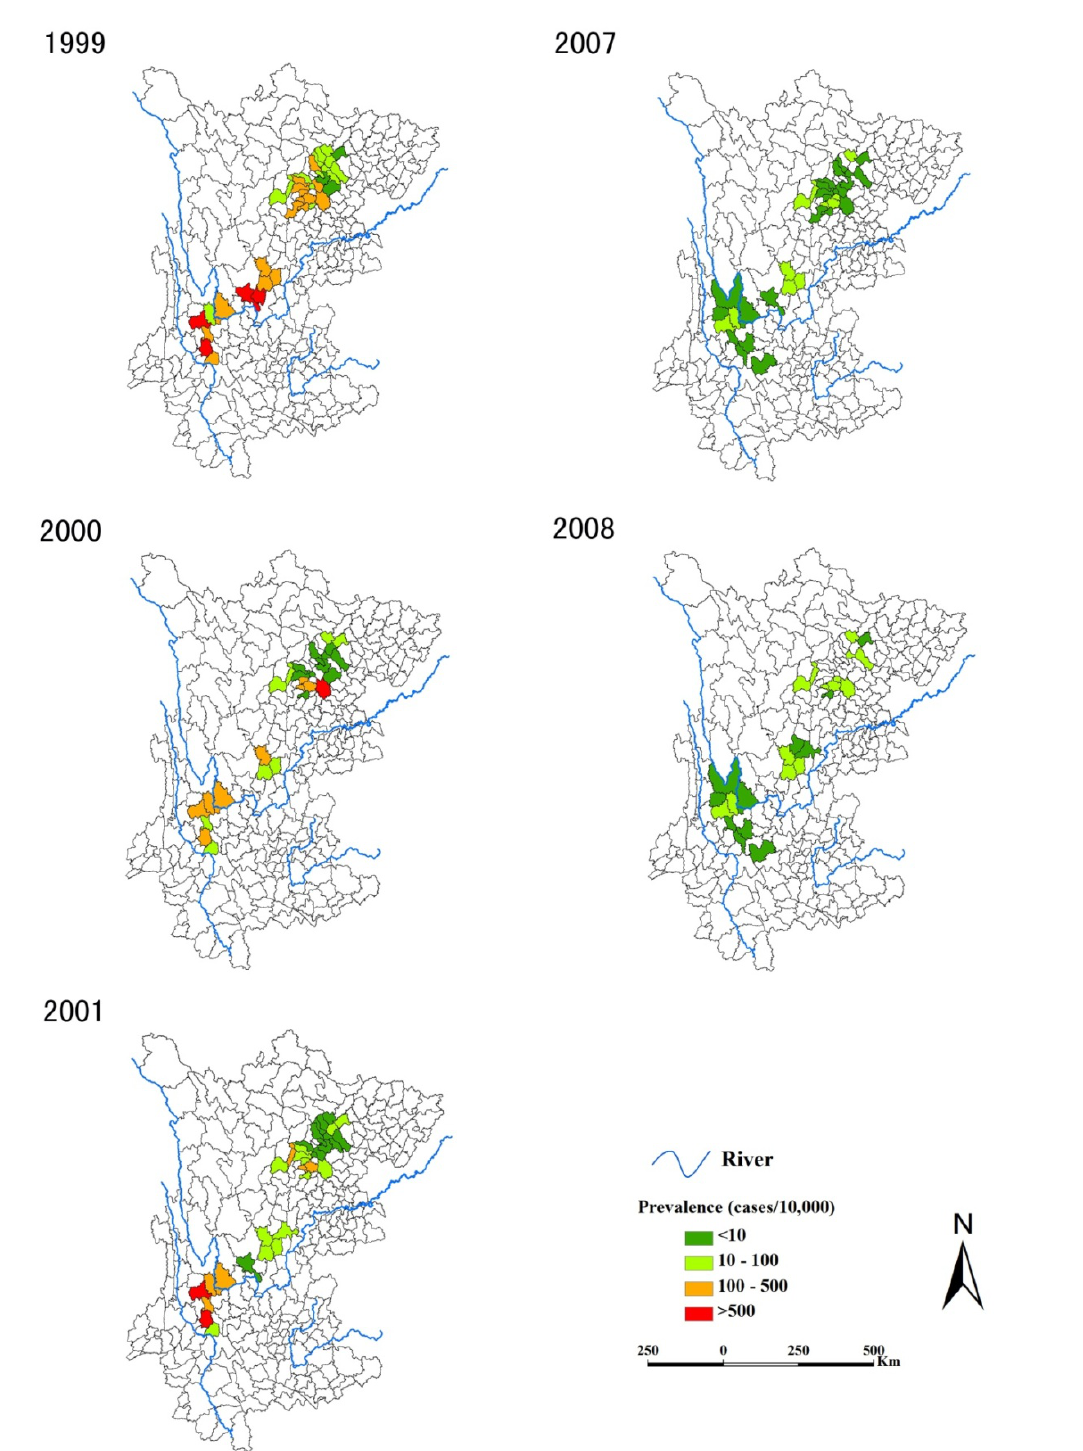
Figure 2. Annual prevalence of schistosomiasis at county level during the two study